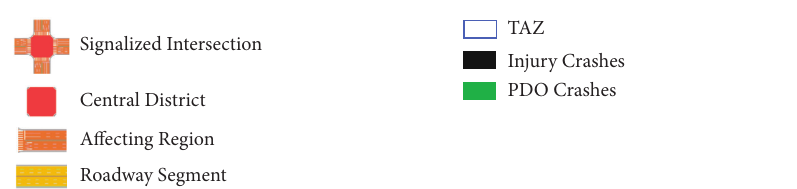
Figure 1: Multiple heterogeneities along the signal-coordinated